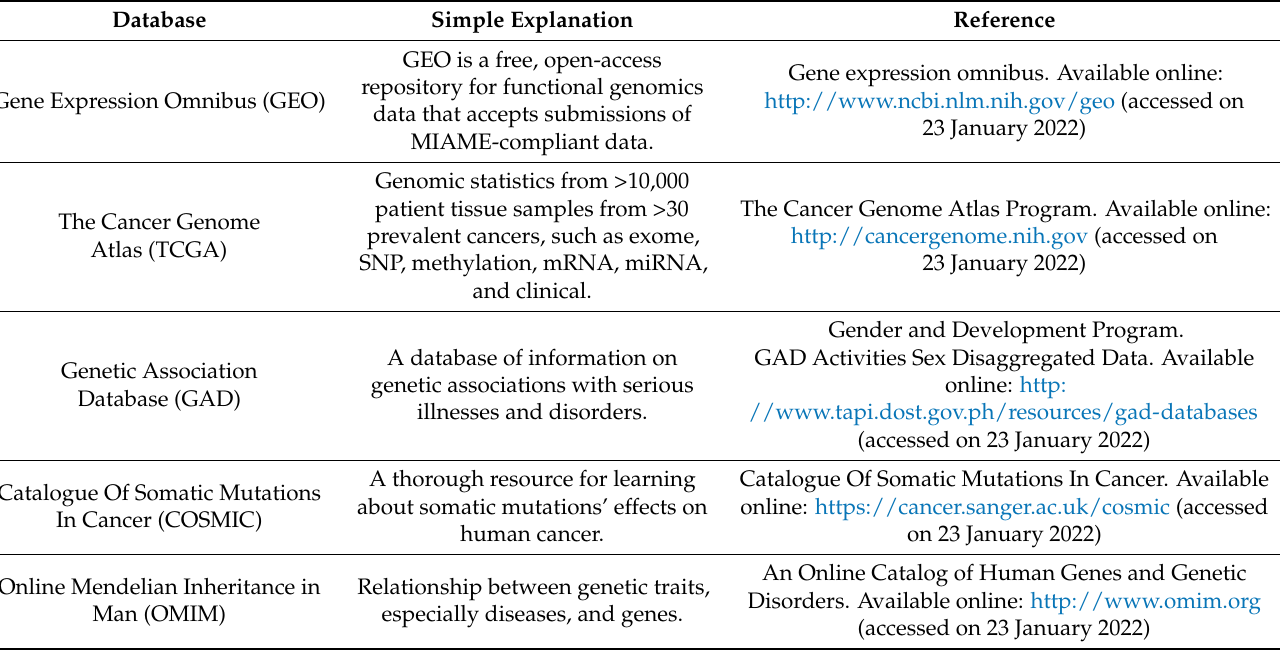
Table 1. Sources of data for determining the correlations between cancer and genes.